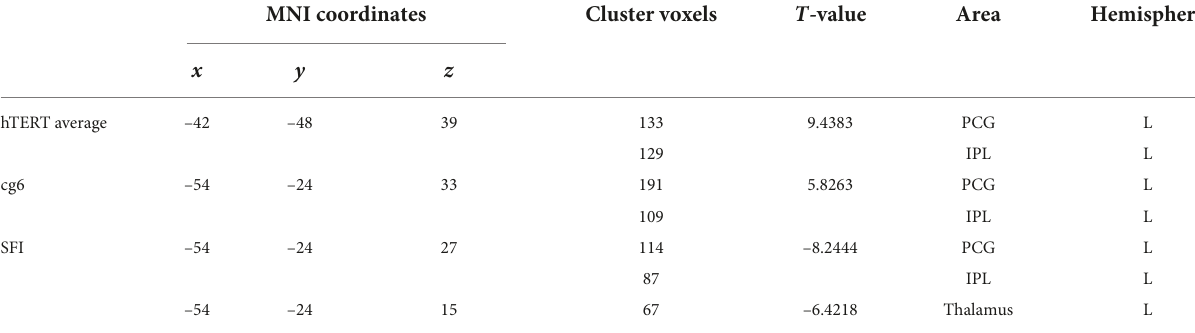
TABLE 2 Significant clusters show the effects of PD and hTERT methylation level on regional homogeneity. MNI coordinates